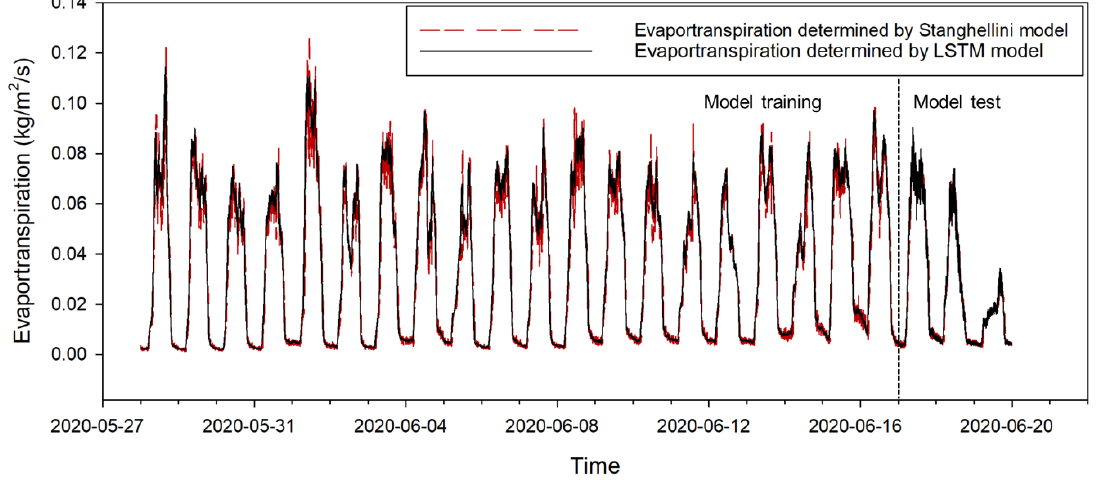
Figure 4. Comparison of the prediction performance between the LSTM-based ET prediction model and the Stanghellini model.